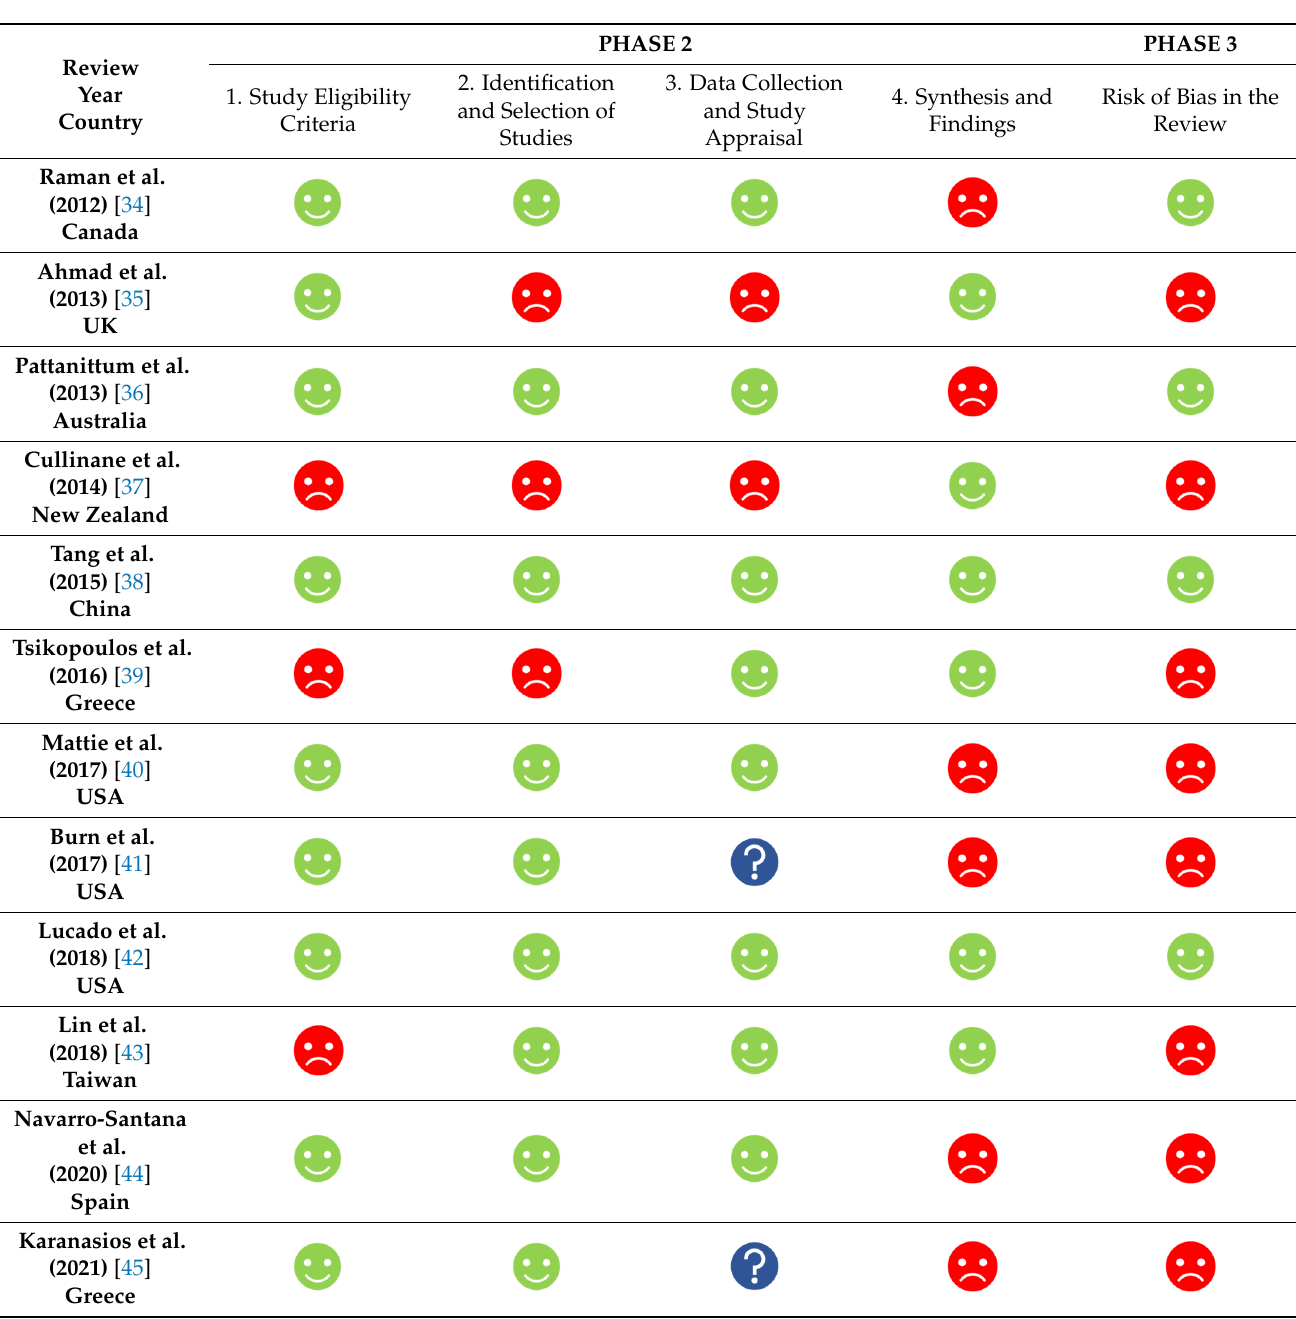
Table 3. Cont. Table 3. RoBis, risk of bias for systematic reviews [18]. Table 3. RoBis, risk of bias for systematic reviews [18]. Table 3. RoBis, risk of bias for systematic reviews [18]. Table 3. RoBis, risk of bias for systematic reviews [18]. Table 3. RoBis, risk of bias for systematic reviews [18].